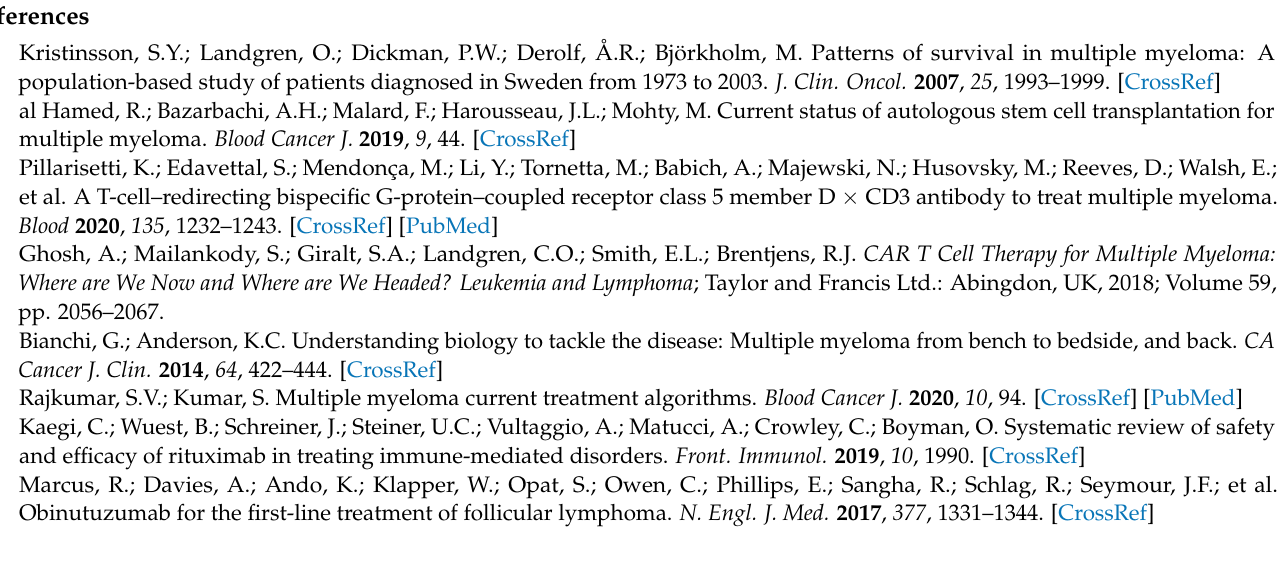
Figure S3: mTOR inhibitor treatments in MM cell lines; Figure S4: Temsirolimus and trametinib act synergistically in MM cell lines; Figure S5: Original Western blots for Figure 1A; Figure S6: Original Western blots for Figure 1B; Figure S7: Original Western blots for Figure 2A; Figure S8: Original Western blots for Figure 2C; Figure S9: Original Western blots for Figure 3A; Figure S10: Original Western Blots for Figure 3E.; Table S1: MM cell lines based on cytogenetics; Table S2: IC50 values of 11 MM cell lines for pictilisib, temsirolimus, and